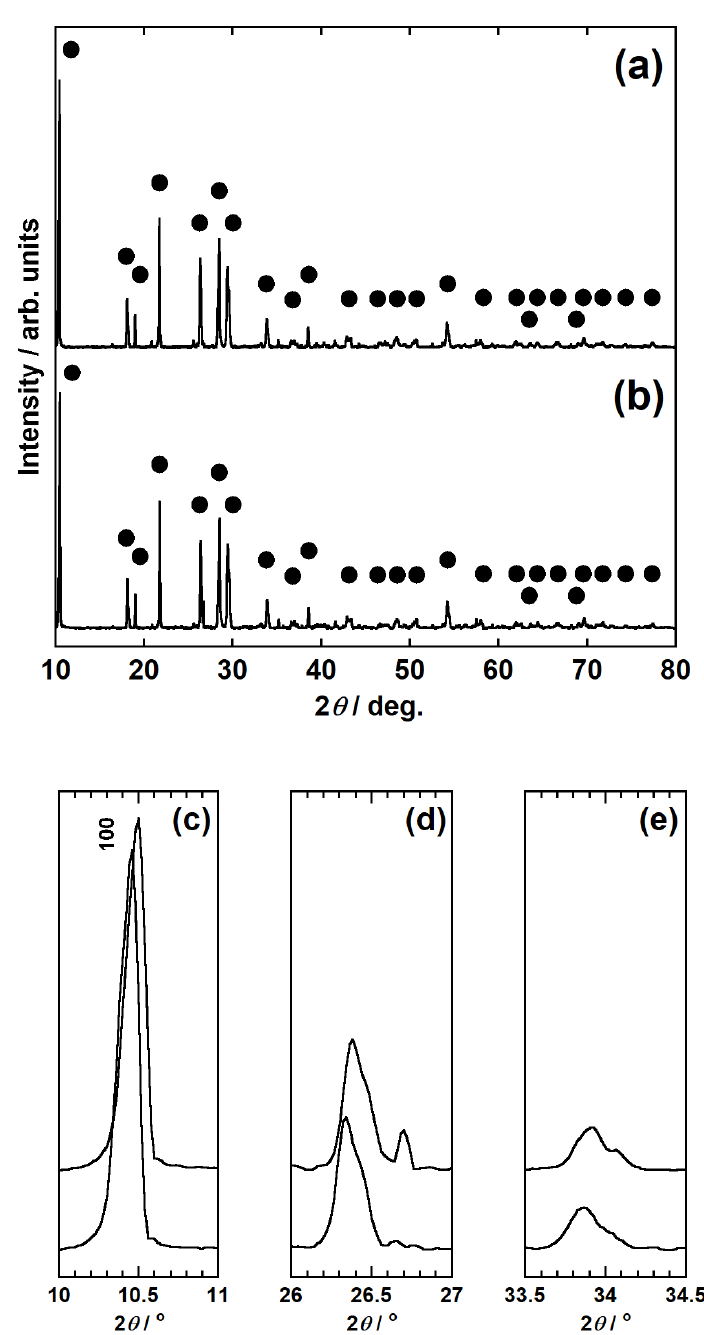
Figure 4. X-ray diffraction (XRD) profiles of the spent autocatalyst samples obtained ( a ) before calcination (condition I-A) and ( b ) after calcination at 800 °C for 3 h (condition I-B). The black circles indicate the cordierite phase. ( c – e ) Enlarged XRD profiles of the spent autocatalyst samples. Lower plot: condition I-A; upper plot: condition I-B.